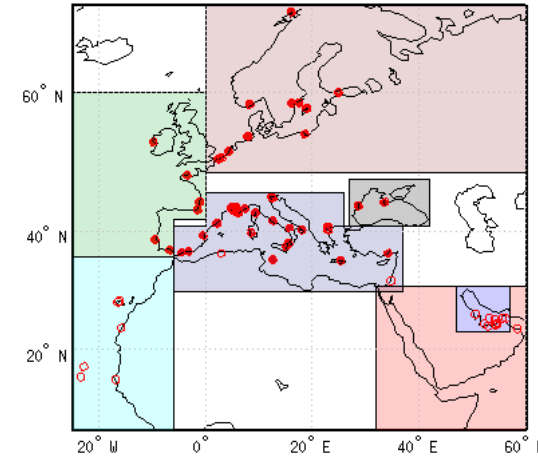
Figure 1. The study region (5–70 ◦ N, 25 ◦ W–60 ◦ E) and the loca- tion of 69 AERONET stations used for validation of MODIS satel- lite aerosol asymmetry parameter ( g aer ) data. Solid red circles de- note stations located in Europe and hollow red circles are stations in Africa, the Middle East and the Arabian Peninsula. Also shown are seven sub-regions selected for studying the seasonal variation of g aer